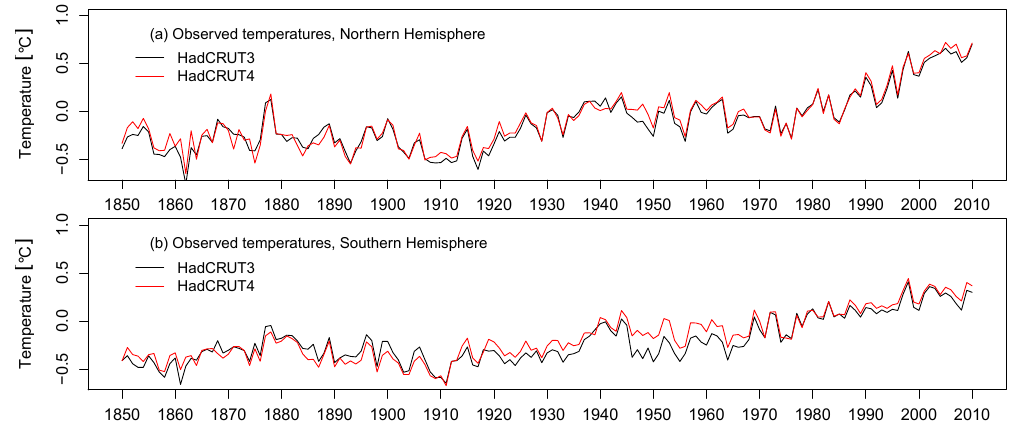
Fig. B2. Annual temperature data. HadCRUT3, University of East Anglia and the Hadley Centre; HadCRUT4, University of East Anglia, King Abdulaziz University and the Hadley